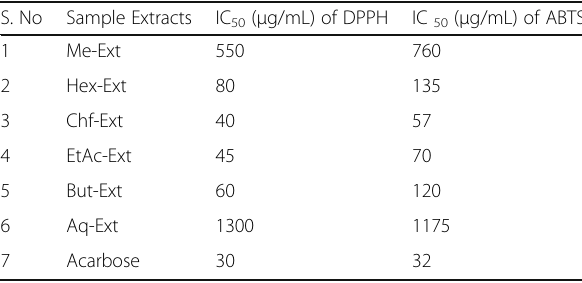
Table 3 DPPH and ABTS free radical Scavenging activity of E. umbellata Thunb. fruit Me-Ext and various